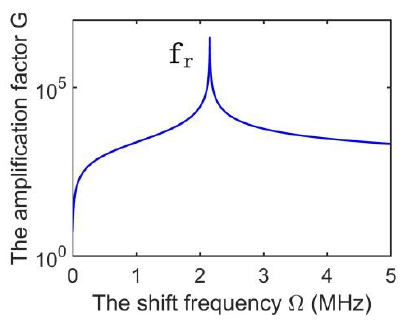
Figure 3. The relationship between the amplification factor G and the shift frequency Ω.